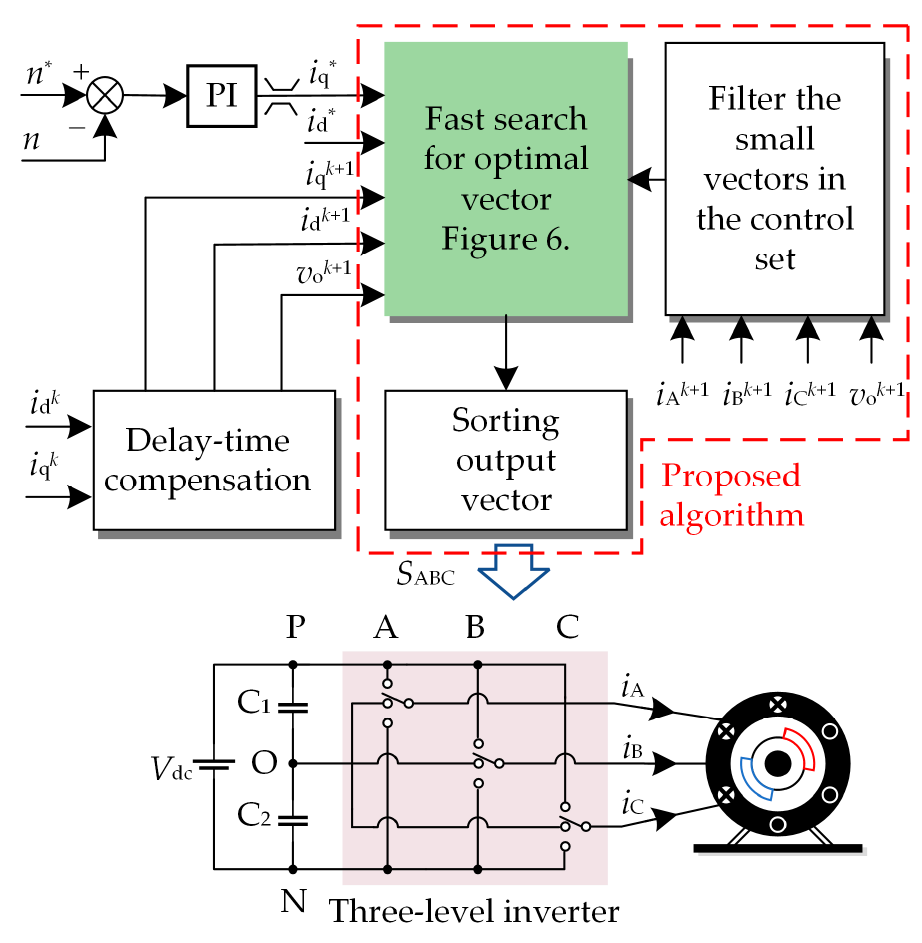
Figure 9. Structure block diagram of ECS-MPCC.